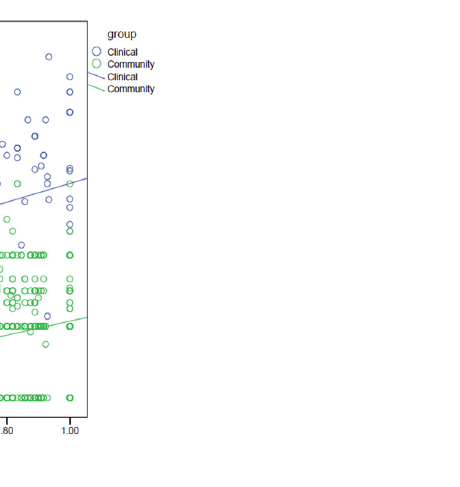
Fig 4. Association between attributional biases and level of delusional